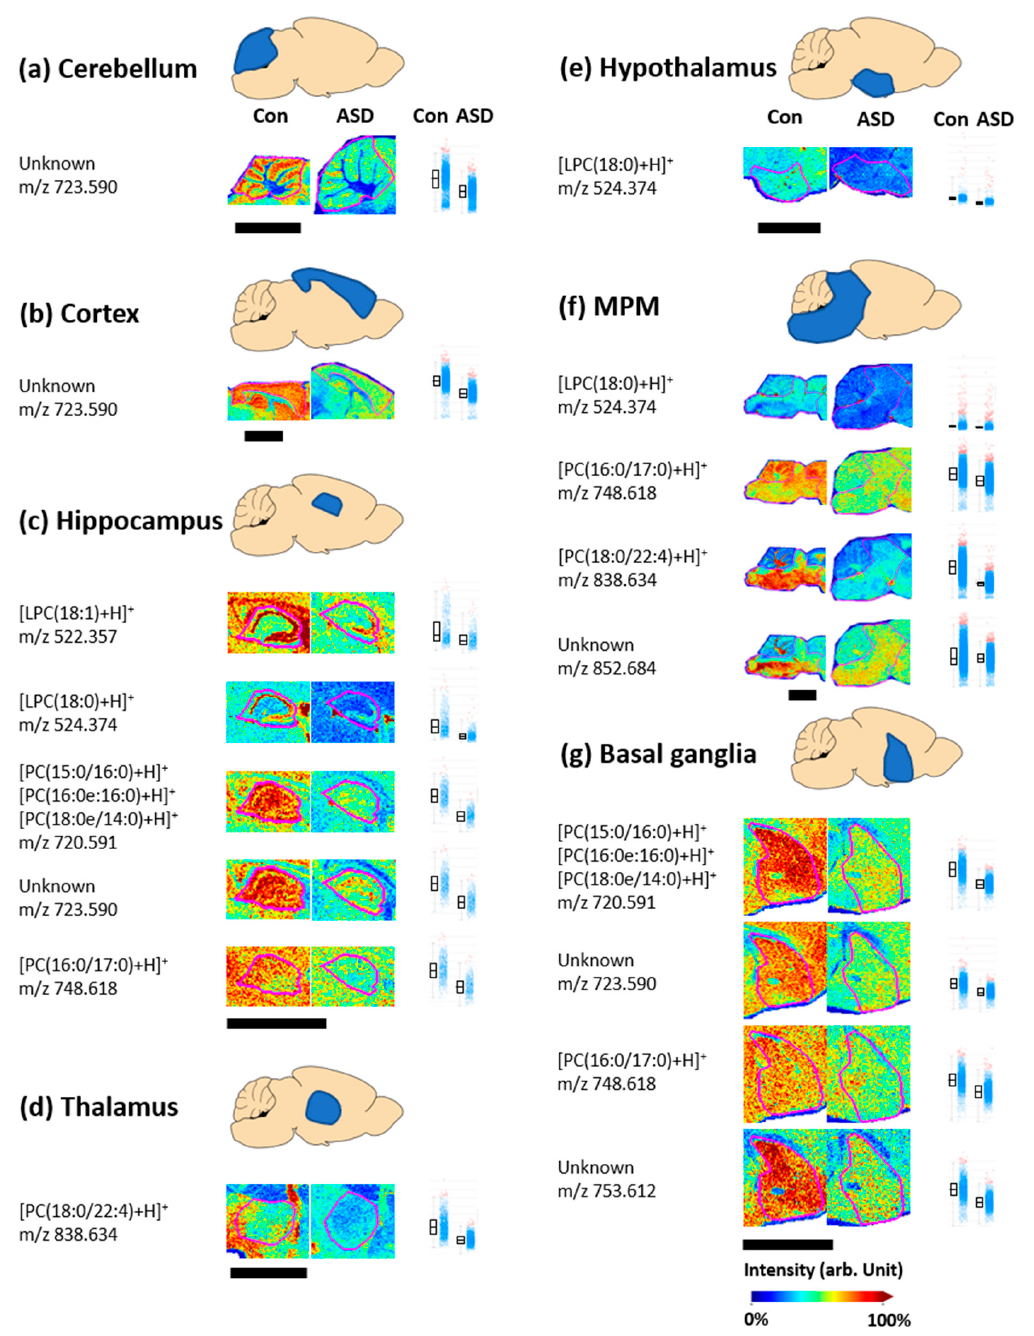
Figure 4. Matrix-assisted laser desorption/ionization mass spectrometry imaging (MALDI-MSI) results and intensity box plots of positively charged phospholipid ions detected in the control (Con) and valproic acid-induced autism spectrum disorder model (ASD) groups. Comparison of the relative intensity of positively charged phospholipids was performed in the cerebellum ( a ), cortex ( b ), hippocampus ( c ), thalamus ( d ), hypothalamus ( e ), MPM ( f ), and basal ganglia ( g ), respectively. The magenta lines shown in the MALDI results indicate each part of the brain tissue and the scale bars are 3 mm. In the intensity box plots, the y -axis represents the total ion count normalized intensity, and the horizontal line of the box part represents the median intensity defined so that the number of spectra with low and high values are the same. The spectra for which the intensities of specific m / z values are between the lower and upper quantiles are shown by blue dots. Spectra with intensities outside of these intensity intervals are shown by red dots.